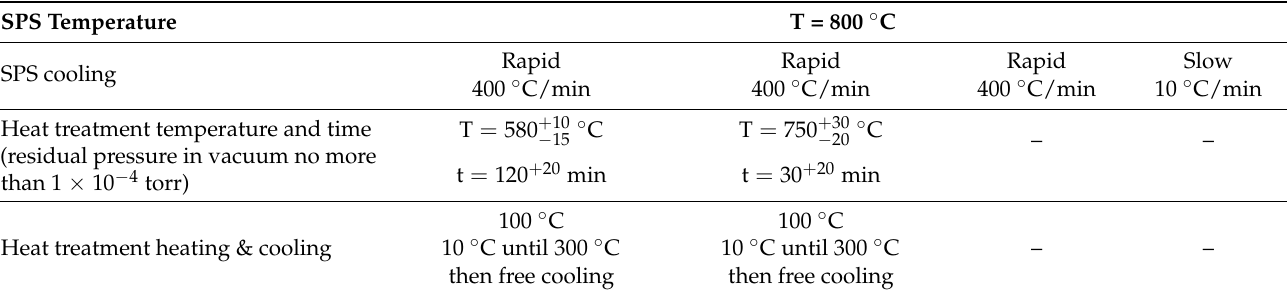
Table 2. Post-SPS heat treatment